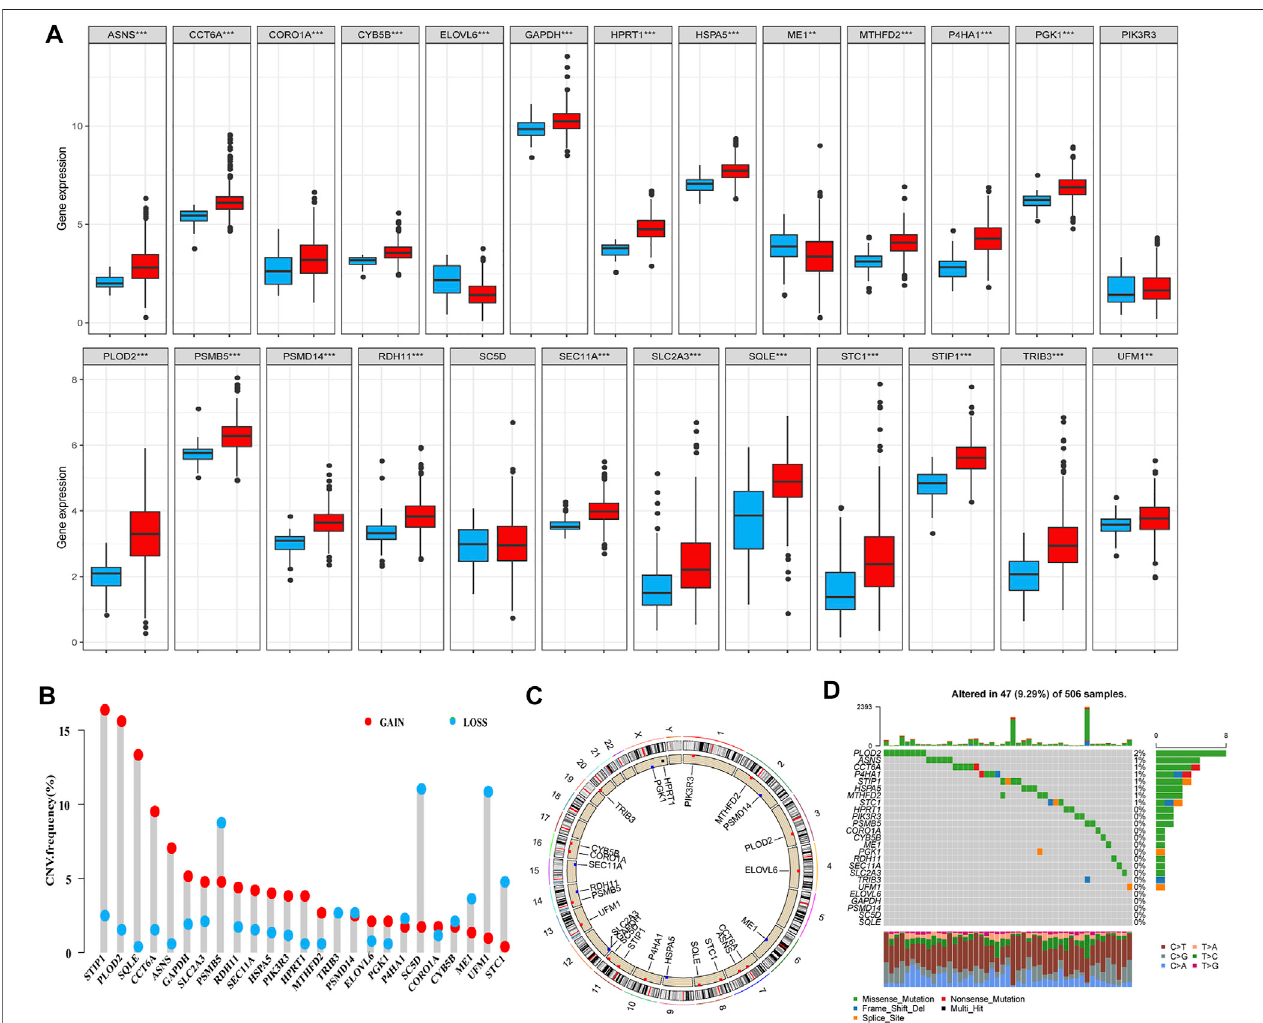
FIGURE 4 | Landscape of genetic and expression variations of 25 prognostic-related genes identi fi ed through the univariate Cox regression analysis. (A) Expression levels of the 25 genes in HNSCC (red) and normal (dew grass color) tissues. (B) CNV frequency of the 25 genes in TCGA cohort. The height of the column representsthealterationfrequency.CNVgain,red;CNVloss,dewgrasscolor. (C) LocationsoftheCNValterationsofthe25geneson23chromosomesinTCGAcohort. (D) Mutation frequency and classi fi cation of the 25 genes in HNSCC (*** p < 0.001 and ** p < 0.01). Abbreviations: CNV, copy number variation; HNSCC, head and neck squamous cell carcinoma; TCGA, The Cancer Genome